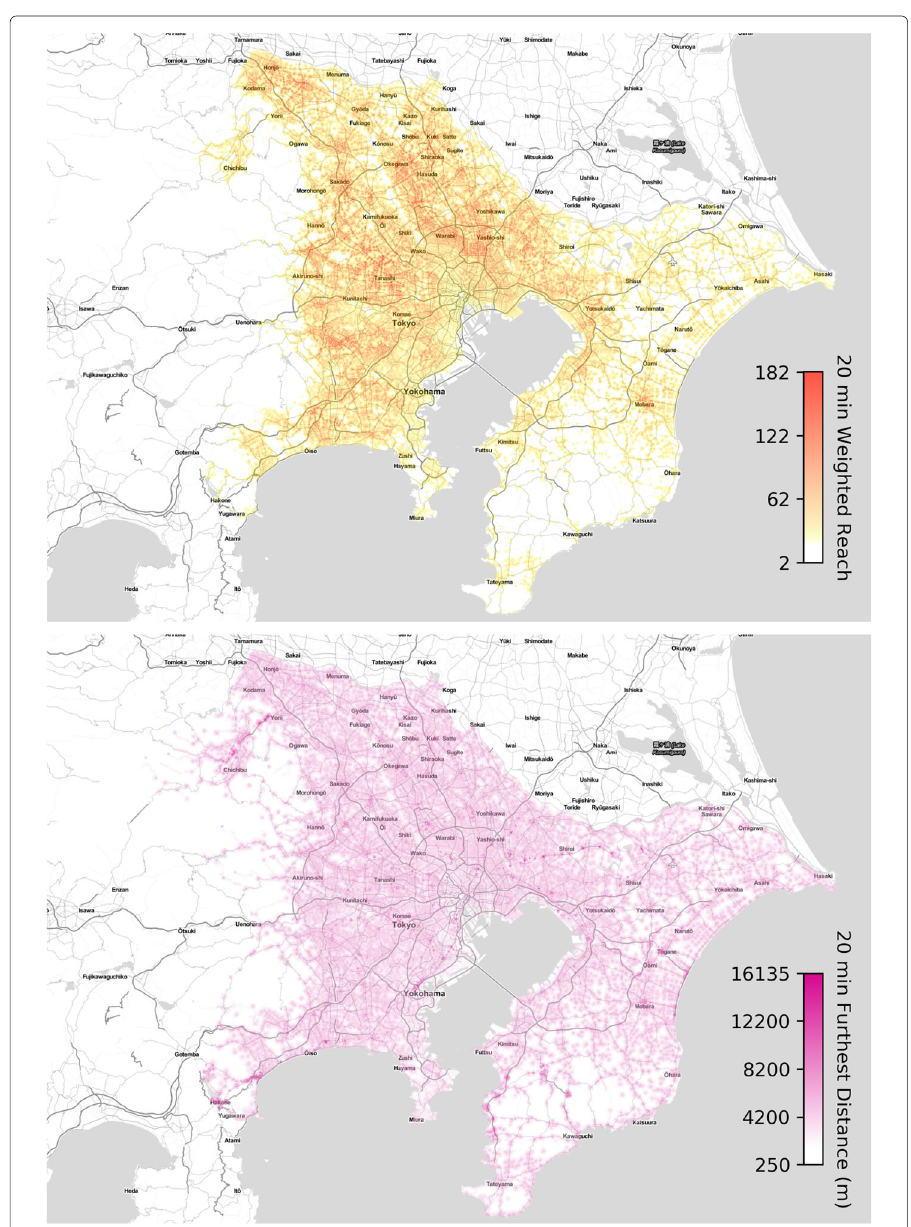
Fig. 10 A map of the Tokyo area showing the 20 min reachability (top) and distance of the furthest point (in meters, bottom) reachable in 20 minutes. Some locations in low reachability areas can reach long distances, for example those near commuter rail stations. Map tiles by Stamen Design (2019), map data by OpenStreetMap Contributors